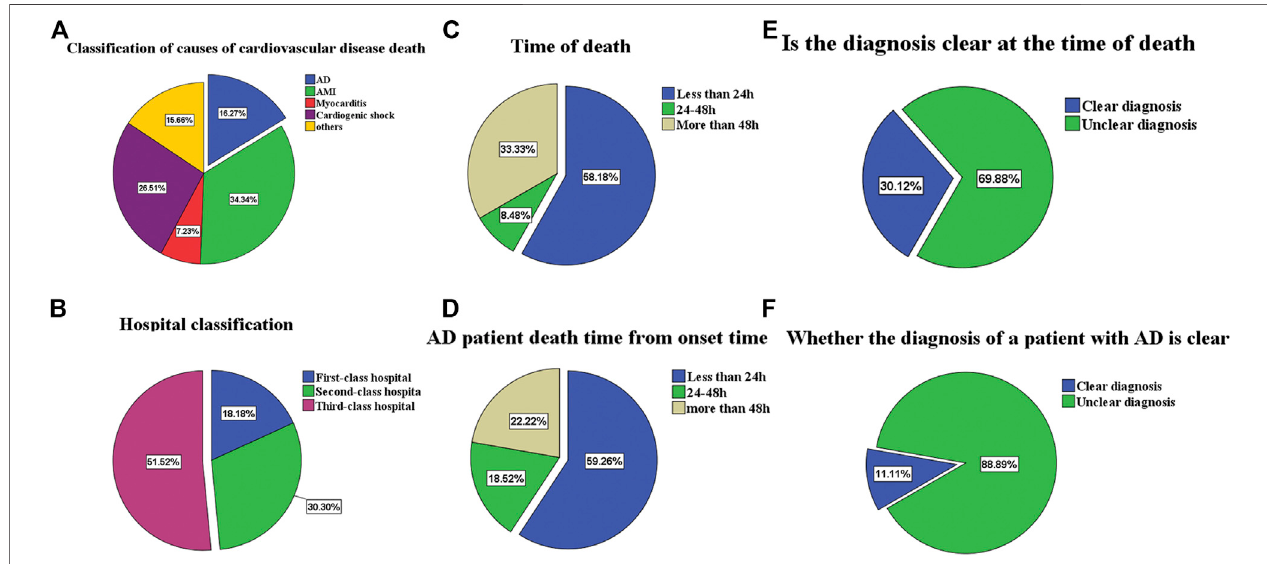
FIGURE3|(A) istheproportionofdeathsfromcardiovascularpatients. (B) isclassi fi cationofhospitalsforthepatients. (C) istheproportionofdifferentdeathtimes ofcardiovascularpatients. (D) isADpatientsdeathtimefromonsettime. (E) istheproportionofunexplained deathatdeath. (F) istheproportion ofunexplaineddeathat death for AD